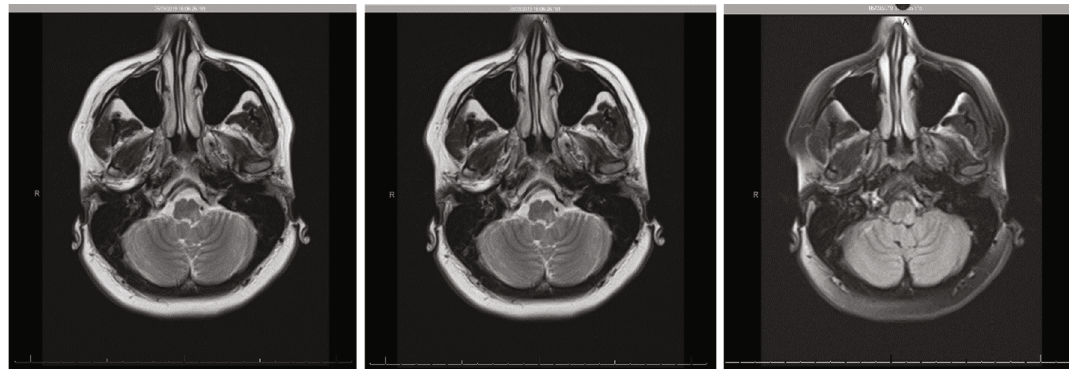
Figure 1: MRI of the brain with and without contrast showing focal restricted di ff usion within the left posterolateral aspect of the medulla with associated focal heterogeneous T2 hyperintense signal, indicative of an evolving focal subacute cerebrovascular accident. Alternatively, this fi nding may represent an acute-subacute focus of demyelination in the proper clinical setting.